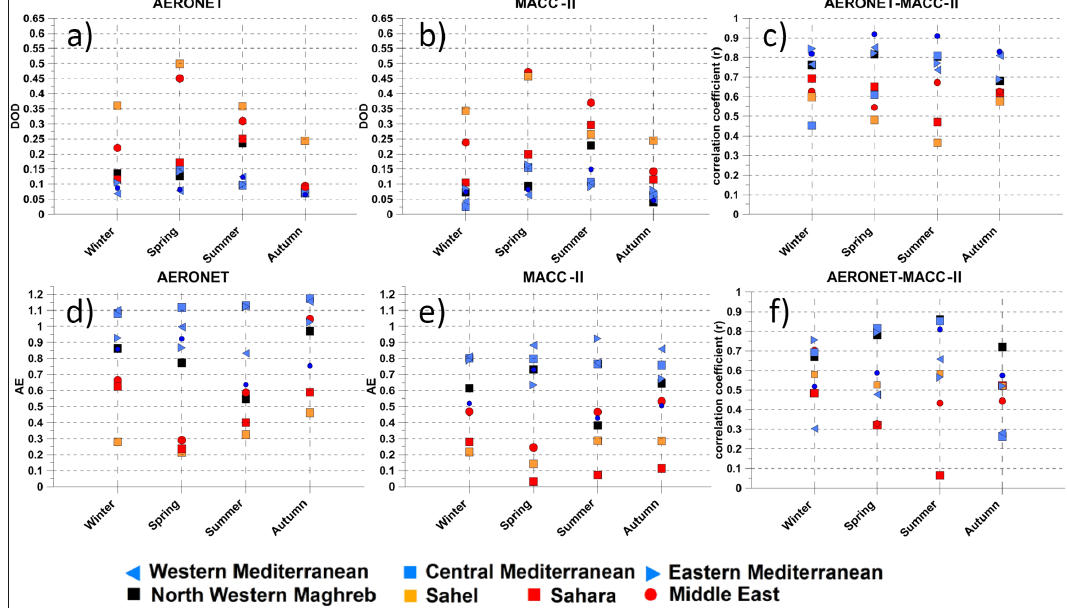
Figure 5. Seasonal averages of AODcoarse (DOD) from AERONET (a) and MACC-II (b) for each region. Seasonal averages of the DOD correlation coefficient (c) for each region. Seasonal averages of AE from AERONET (d) and MACC-II (e) for each region. Seasonal averages of the AE correlation coefficient (f) . This statistics corresponds to the period